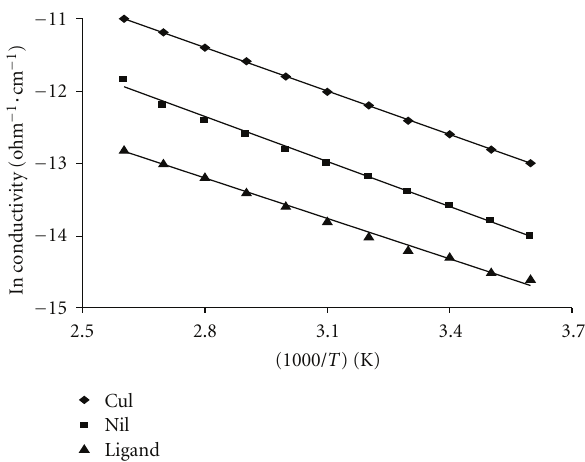
Figure 1: UV-visible spectra of free ligand, Cu-complex, and Ni- complex. Figure 2: The DC conductivities of free ligand, Cu-complex, and Ni-complex before